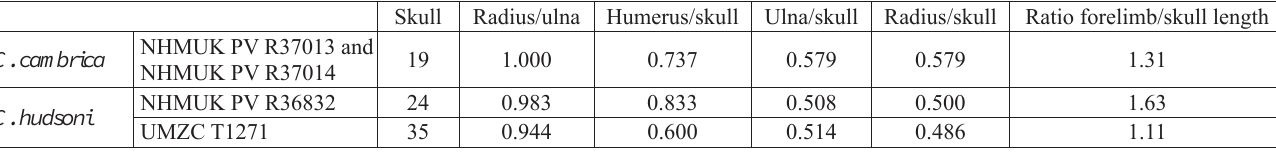
Table 3. Measurements of skull lengths (in mm) and forelimb bone ratios of Clevosaurus cambrica (NHMUK PV R37013 and R37014)